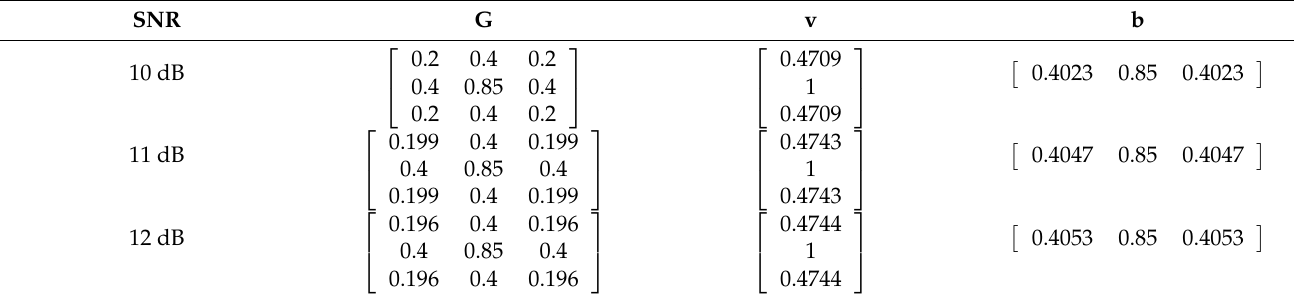
Table 1. Parameters of the target v and b with 1.8 blur and 0% misalignment.